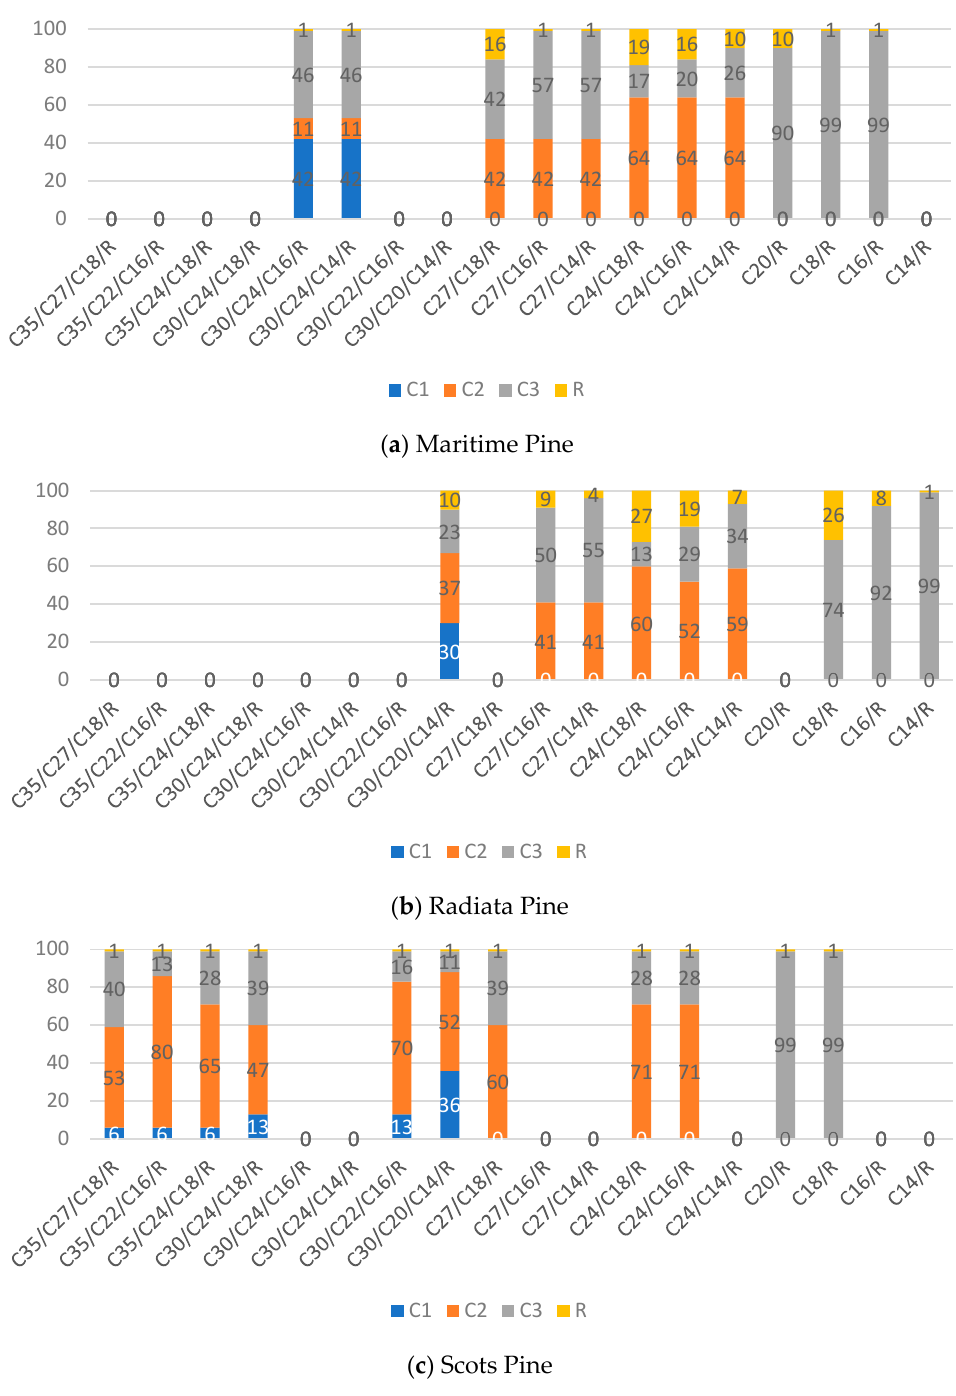
Figure 6. Yields (%) obtained for in-line grading machines by strength class per each species. Note: Empty columns reflect that the strength class combination did not provide a better yield with respect to the immediately higher strength class combination.